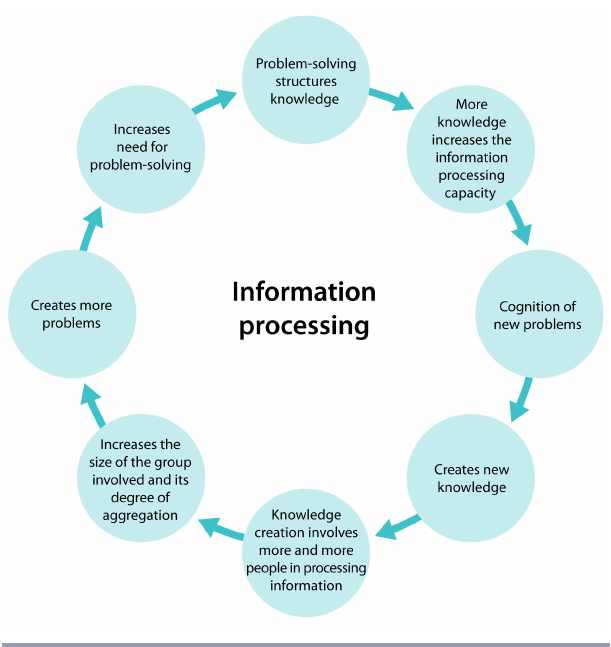
Fig. 1 . The information processing loop (see text; after van der Leeuw